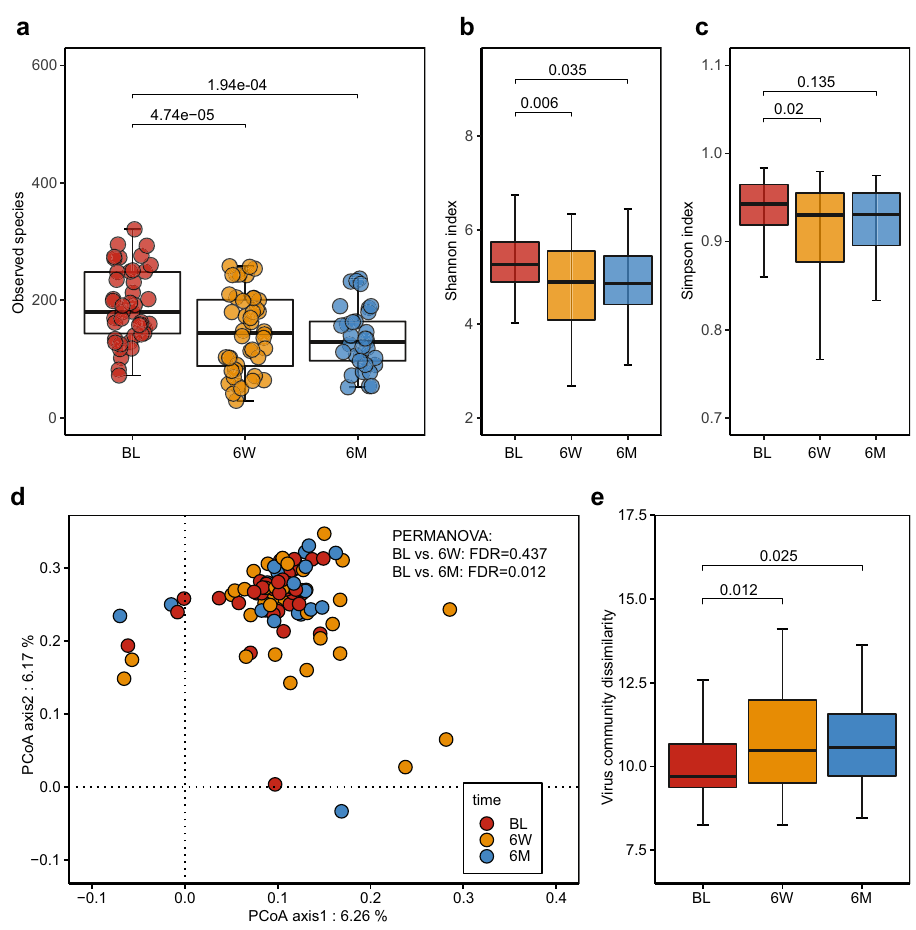
Fig. 2 | Biodiversity alteration of the gut virome community after H. pylori eradication therapy. a – c Comparisons of alpha diversity indices in virus richness ( a ),Shannon index( b ), andSimpson index( c ) among the three groups (BL: N =44; 6W: N =44; 6M: N =33; N , the number of patients in each group). Two-sided Wil- coxon tests followed by BH correction were applied. d Principal Coordinate Ana- lysis(PCoA)ofthegutviromecommunityamongthethreegroups(BL: N =44;6W: N =44; 6M: N =33). Assessed via PERMANOVA test followed by p -value correction